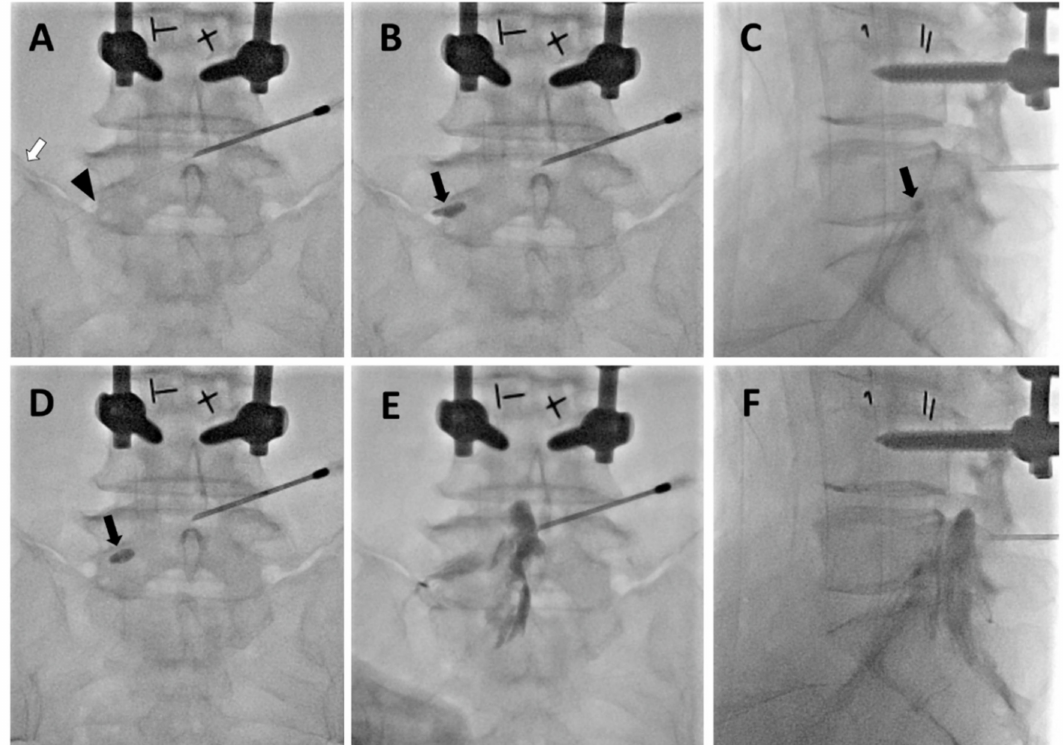
Figure 3. Serial fluoroscopic images of transforaminal balloon treatment via a retrograde interlaminar approach in patient H (see Table 1). ( A ) The foraminal balloon catheter with guidewire was inserted to the extraforaminal space through a guide needle, which was inserted via a retrograde interlaminar approach because of the patient’s high iliac crest (white arrow). The position of the foraminal balloon catheter can be checked with a fluoroscopic image of the guidewire (arrow head). ( B ) The foraminal balloon catheter was placed in the left L5–S1 intervertebral neural foramen. During ballooning with contrast medium, the grade of foraminal stenosis was visualized by the degree of balloon distortion (black arrow). ( C ) Lateral view in ( D ) Balloon treatment was performed by gradually pulling the catheter backward (black arrow). ( E )